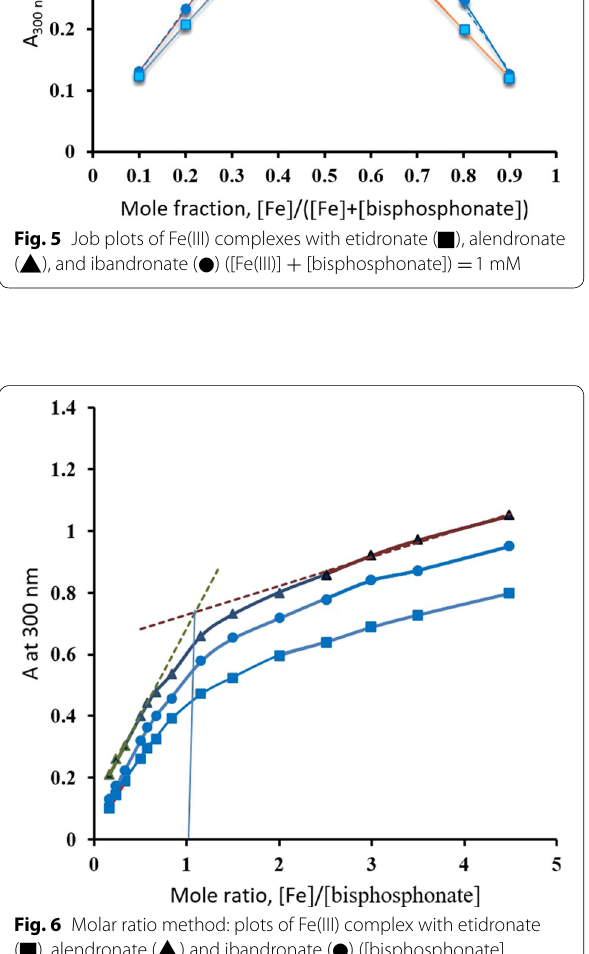
Fig. 6 Molar ratio method: plots of Fe(III) complex with etidronate ( ■ ), alendronate ( ▲ ) and ibandronate ( ● ) ([bisphosphonate] 0.5 =